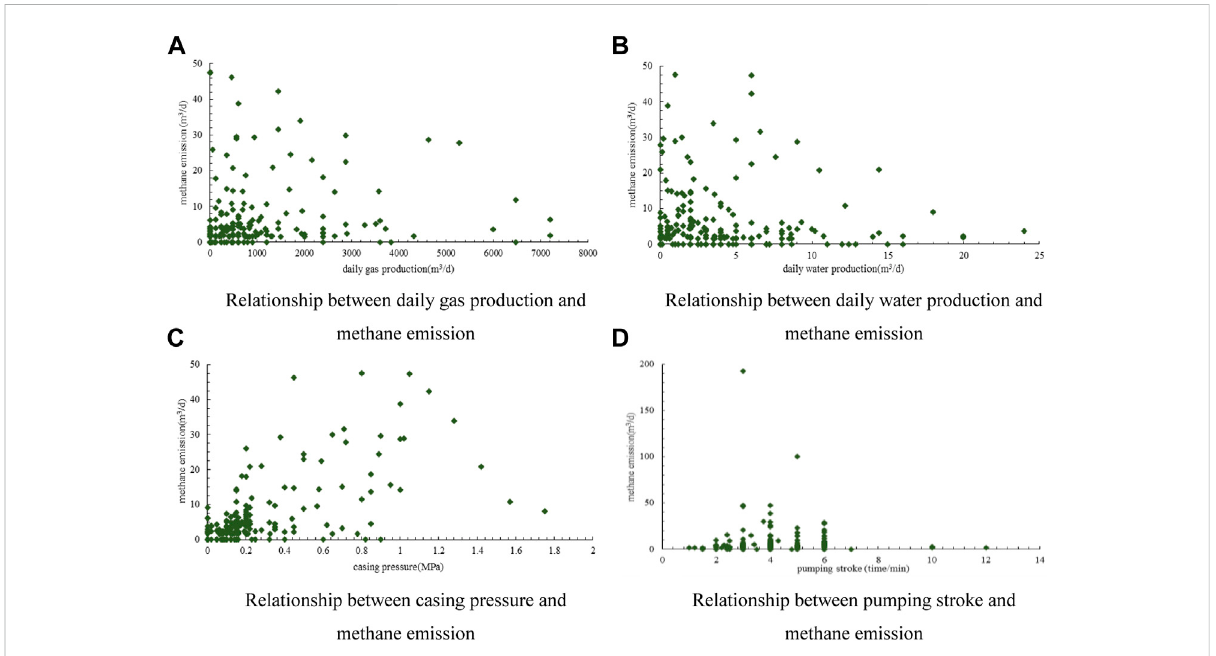
FIGURE 6 Single factor analysis of methane emission in CBM wells (A) Relationship between daily gas production and methane emission (B) Relationship between daily water production and methane emission (C) Relationship between casing pressure and methane emission (D) Relationship between pumping stroke and methane emission.